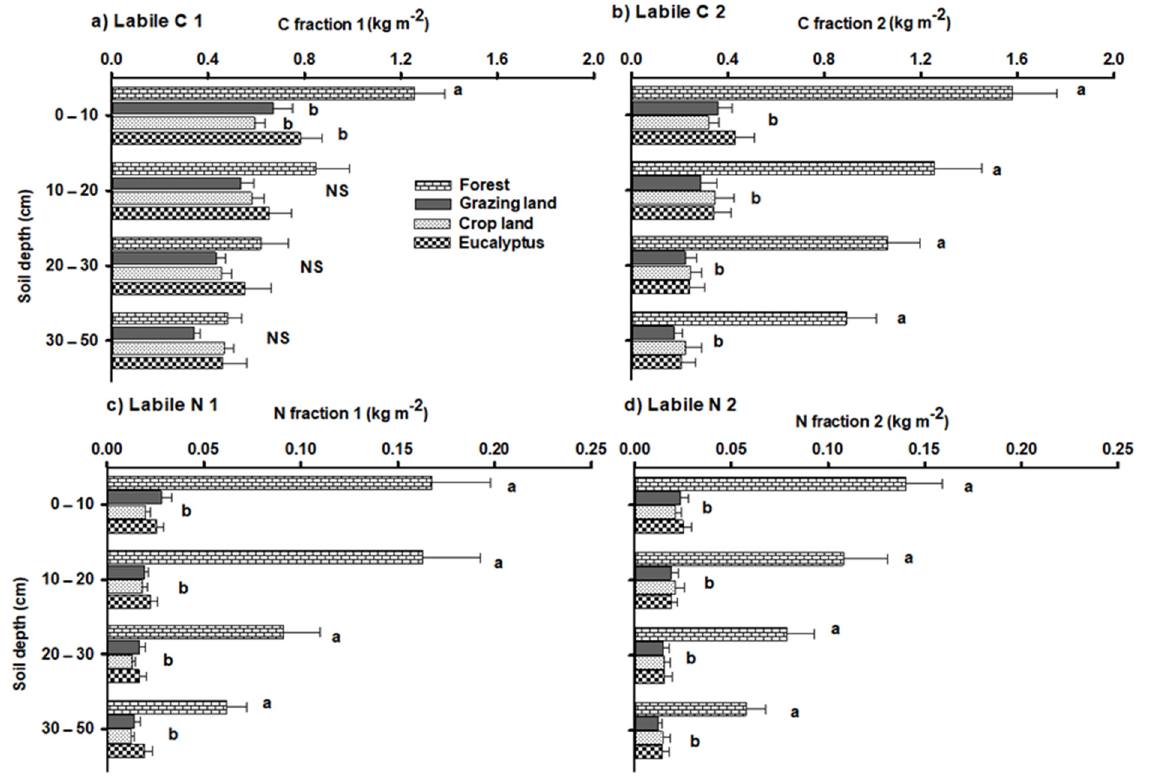
Figure 3. Vertical distributions of labile C and N stocks in soils of natural forest, grazing and crop lands and eucalyptus plantation. ( a ) Labile C fraction 1, ( b ) labile C fraction 2, ( c ) labile N fraction 1 and ( d ) labile N fraction 2. Labile fraction 1 represent easily biodegradable fraction, i.e., carbohydrate, amino acids, while labile fraction 2 constitutes cellulosic compounds. Bar means stock ( n = 5, ± SE), bars without same alphabet are statistically significant ( p ≤ 0.05). NS, non-significant. Table 2. ANOVA results of soil labile (fraction 1 and 2) and recalcitrant (fraction 3) C and N at different soil depths and various land-uses and land-use × depth